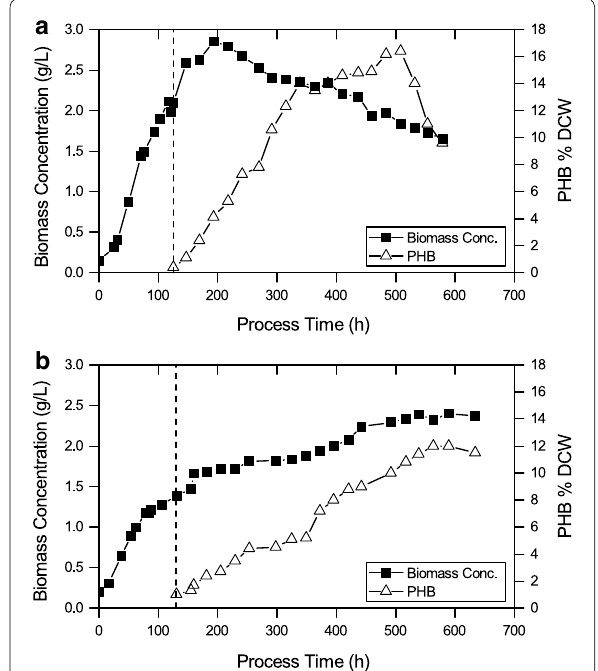
Fig. 4 Time course of growth and PHB accumulation under nitrogen and phosphorus limitation for photobioreactor cultivations of Syn- echocystis sp. PCC 6714 for a growth on nitrate b growth on ammo- nia. *The vertical bar represents the start of the limitation phase. The